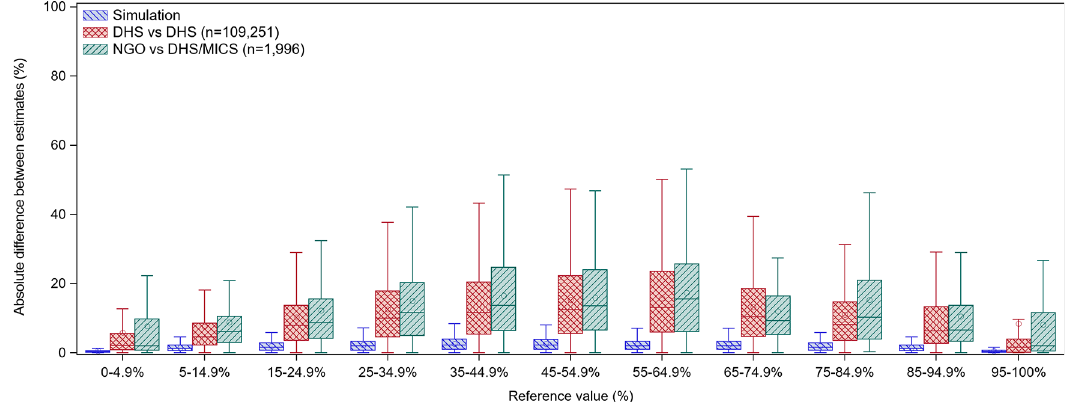
Figure 3. Box plot of absolute difference between NGO and DHS/MICS estimates by the reference value. Absolute difference between estimates calculated as: Simulation: Simulated estimate 1 - Simulated estimate 2 DHS vs DHS: DHS estimate - DHS mimicking the NGO estimate (lower geographical level, more recent year of data collection) DHS/MICS vs NGO: DHS/MICS estimate - NGO estimate Reference value: DHS or the estimate mimicking DHS (higher geographical level, earlier year of data collection) Abbreviations: DHS: Demographic and Health Surveys; MICS: Multiple Indicator Cluster Surveys; NGO: non- governmental error. The standard error (SE) for the DHS indicators is greater than 5% in eleven percent of the estimates. An estimate with a standard error of 5% will have a 95% confidence interval of ± 9.8%.